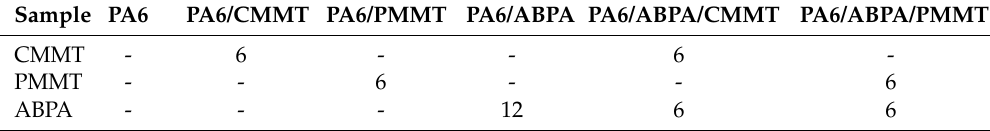
Table 1. Compositions of the studied materials in wt %.